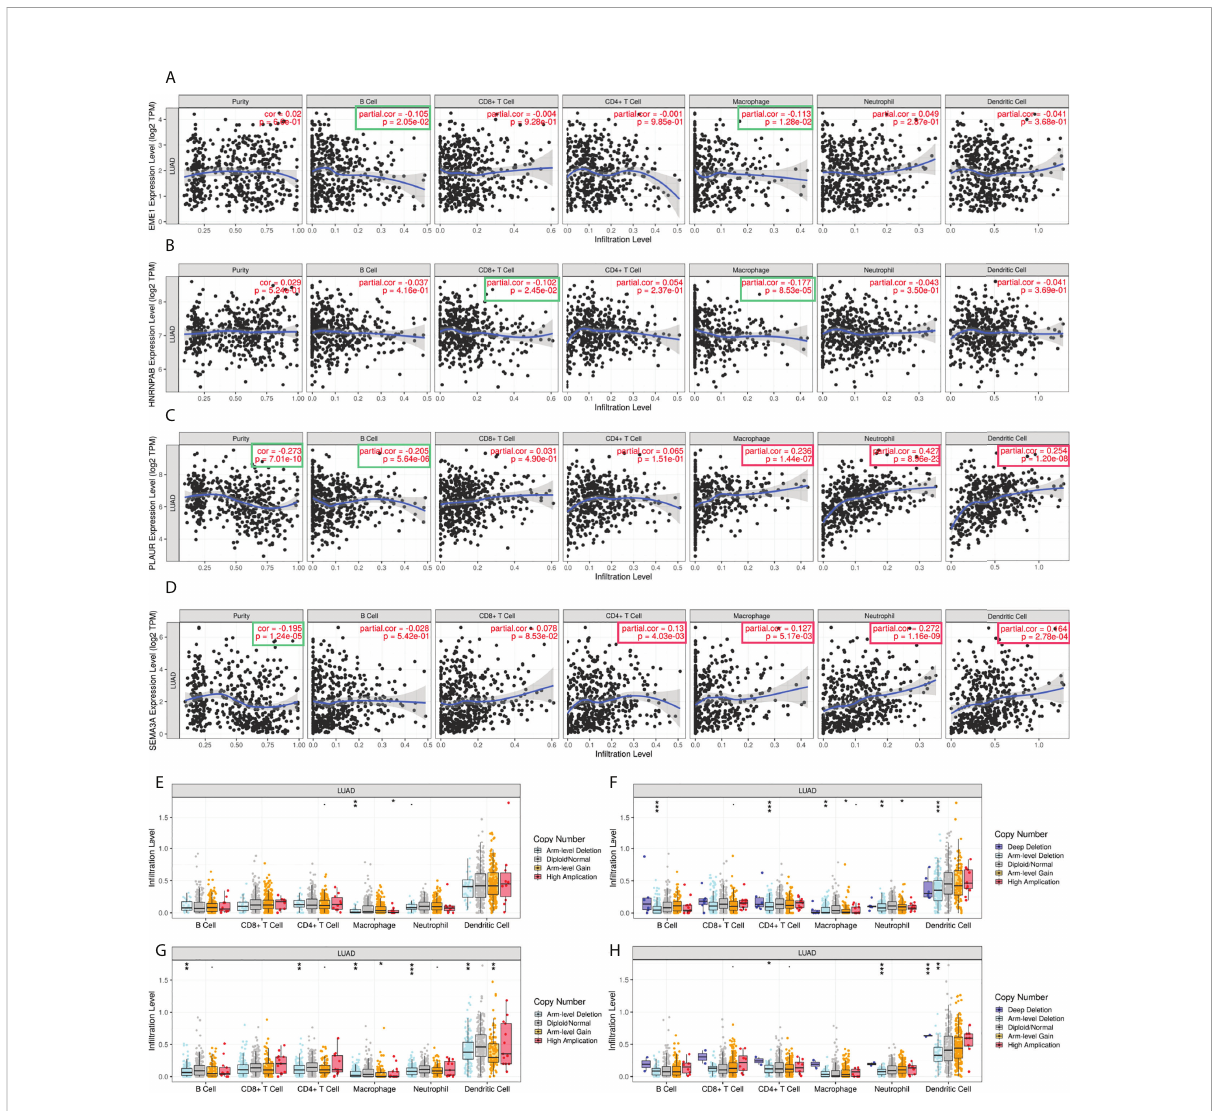
FIGURE 10 The correlation analysis of predicted target gene expression and immune in fi ltration. (A – D) Gene expression and immune in fi ltration level. (E – H) Gene copy number and immune cell in fi ltration level. *p < 0.05; **p < 0.01; ***p <